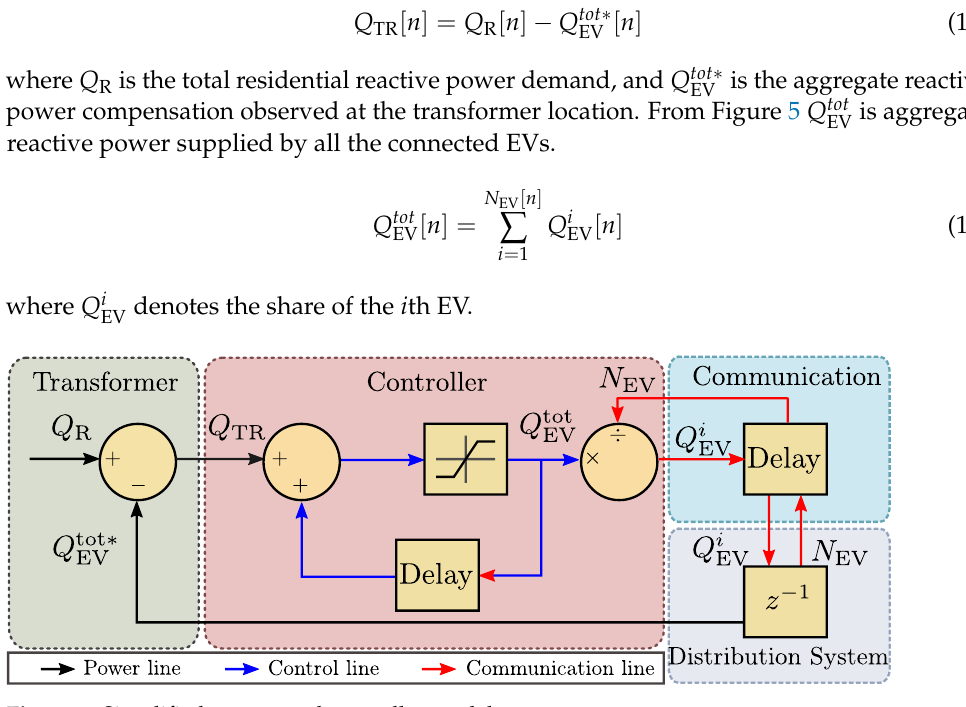
Figure 5. Simplified system and controller